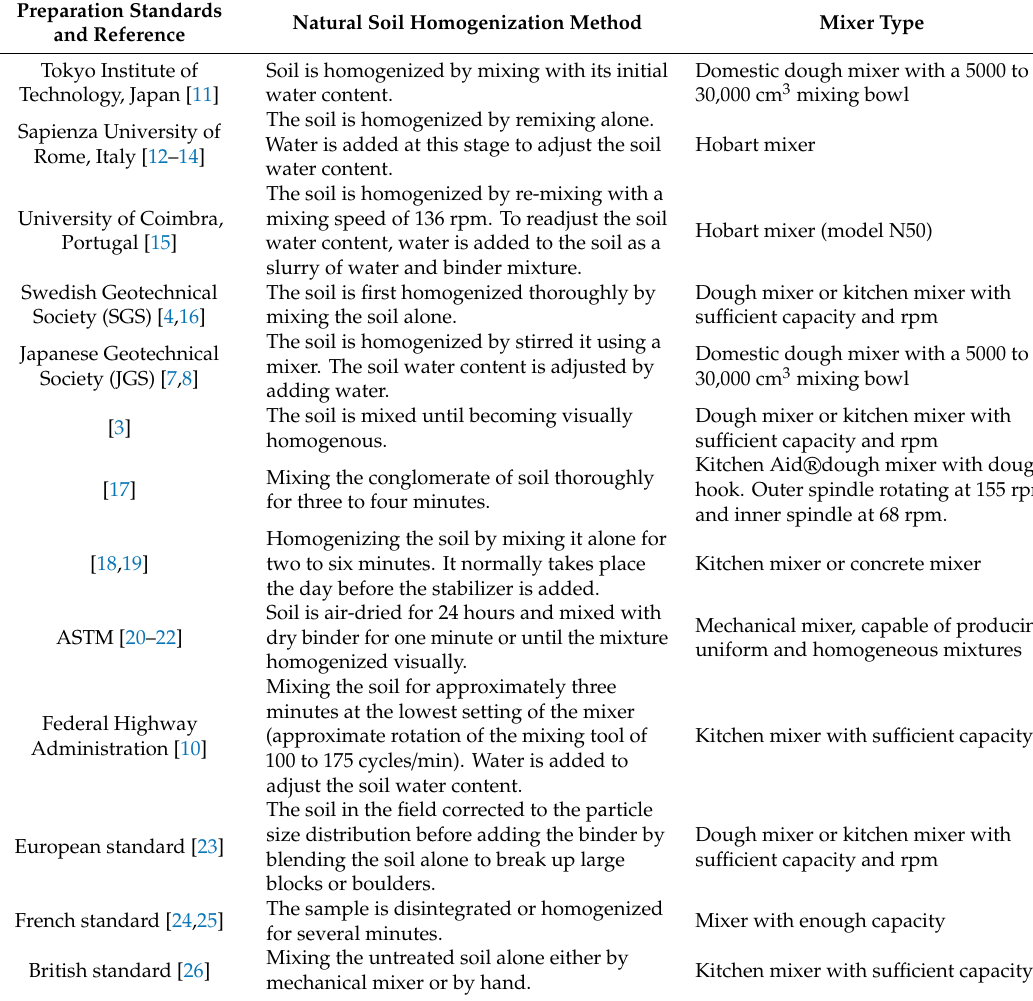
Table 1. Most common procedures for homogenizing natural soil prior to